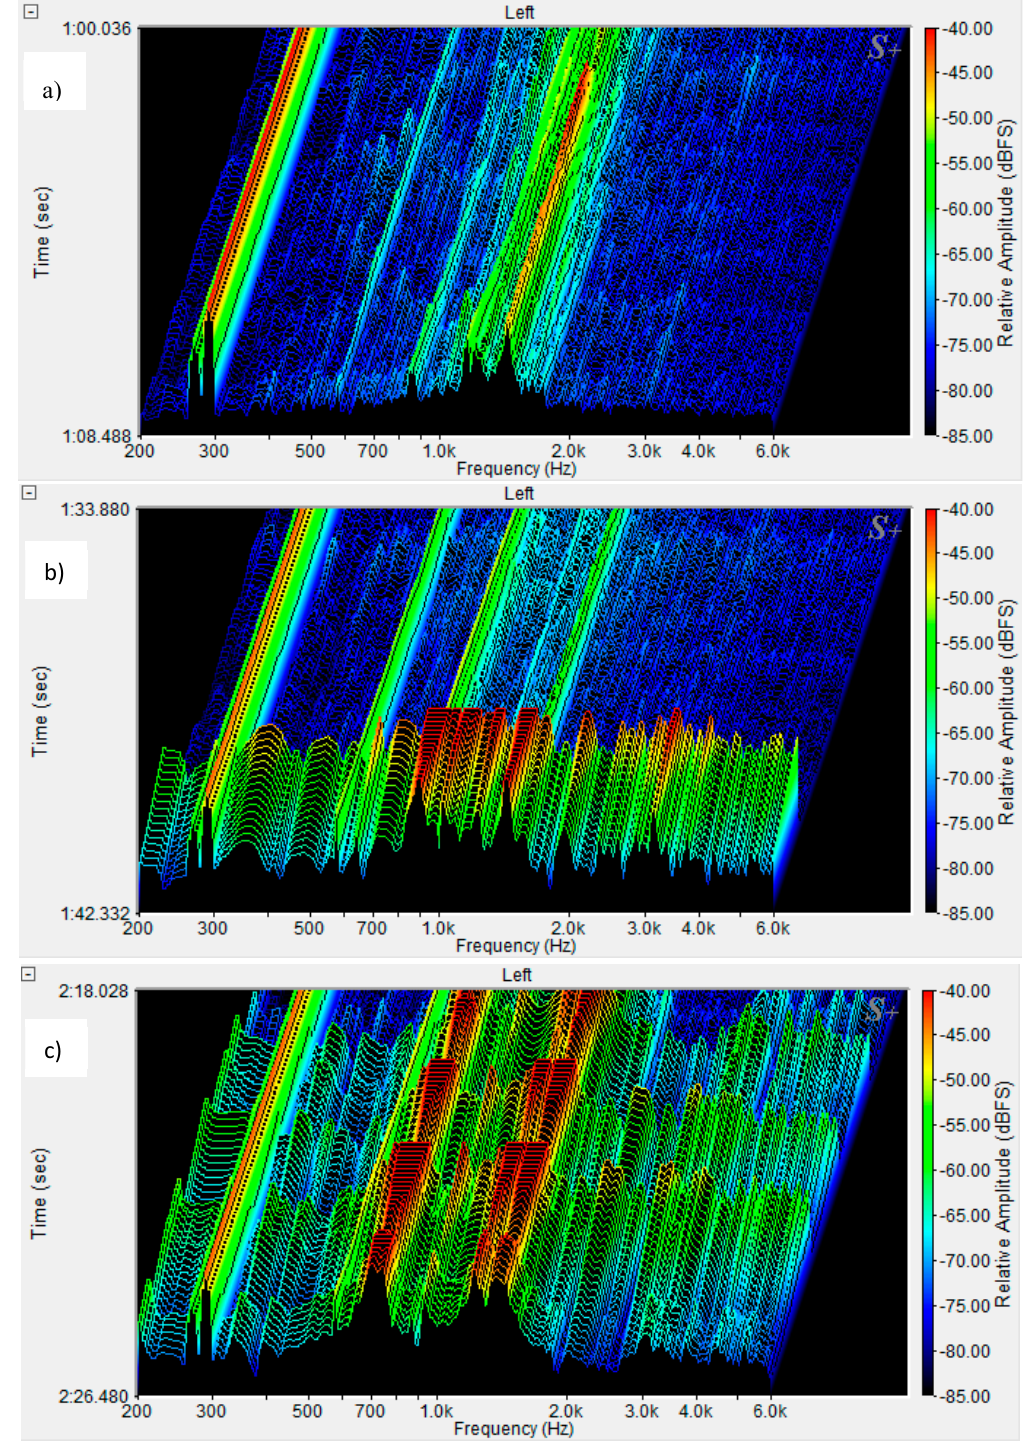
Figure 5. 3D spectrum of ESD composite: ( a ) background noise; ( b ) first crack, f cr ; and ( c ) multicracking.